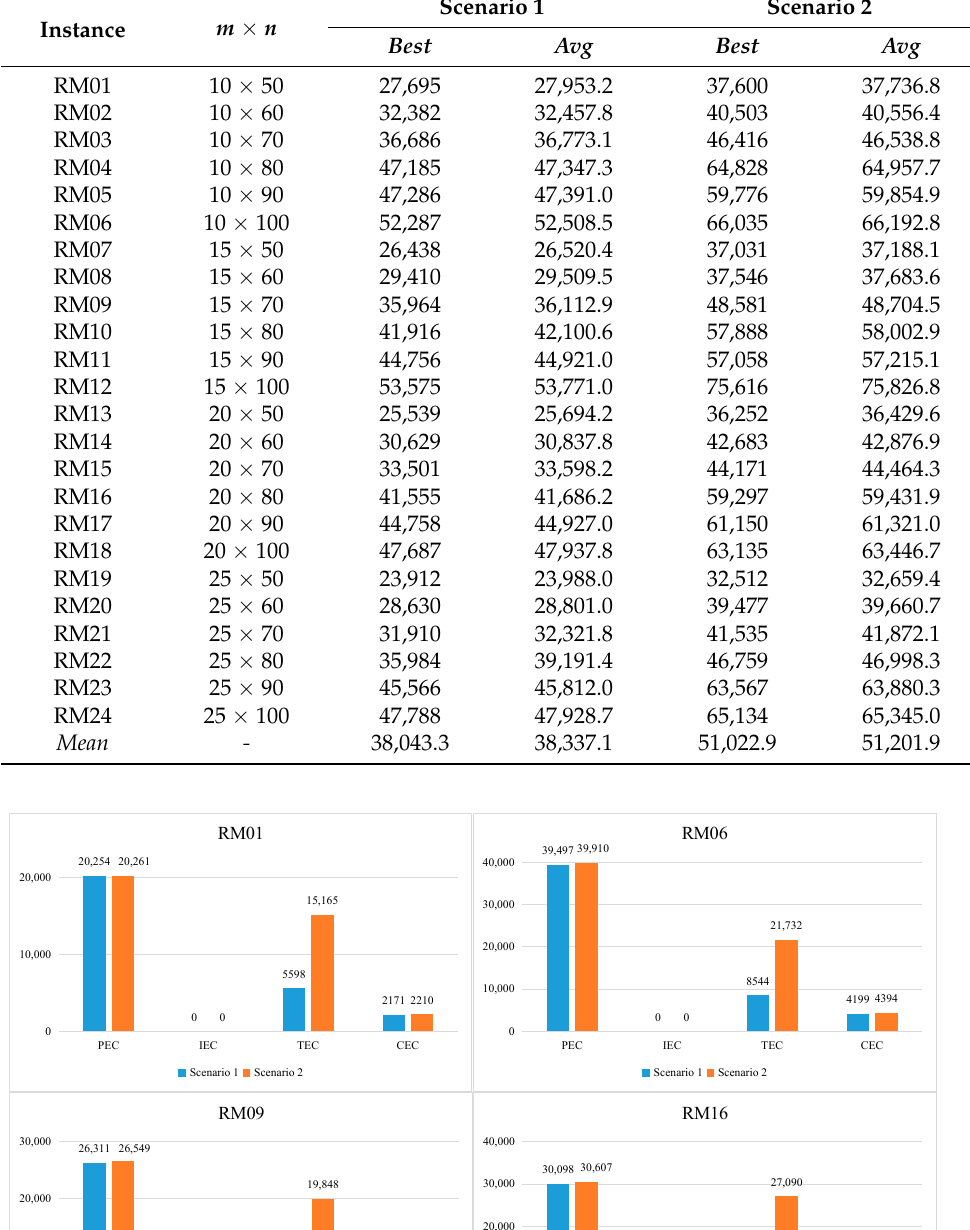
Table 8. Comparison results for two scenarios with different transportation times.